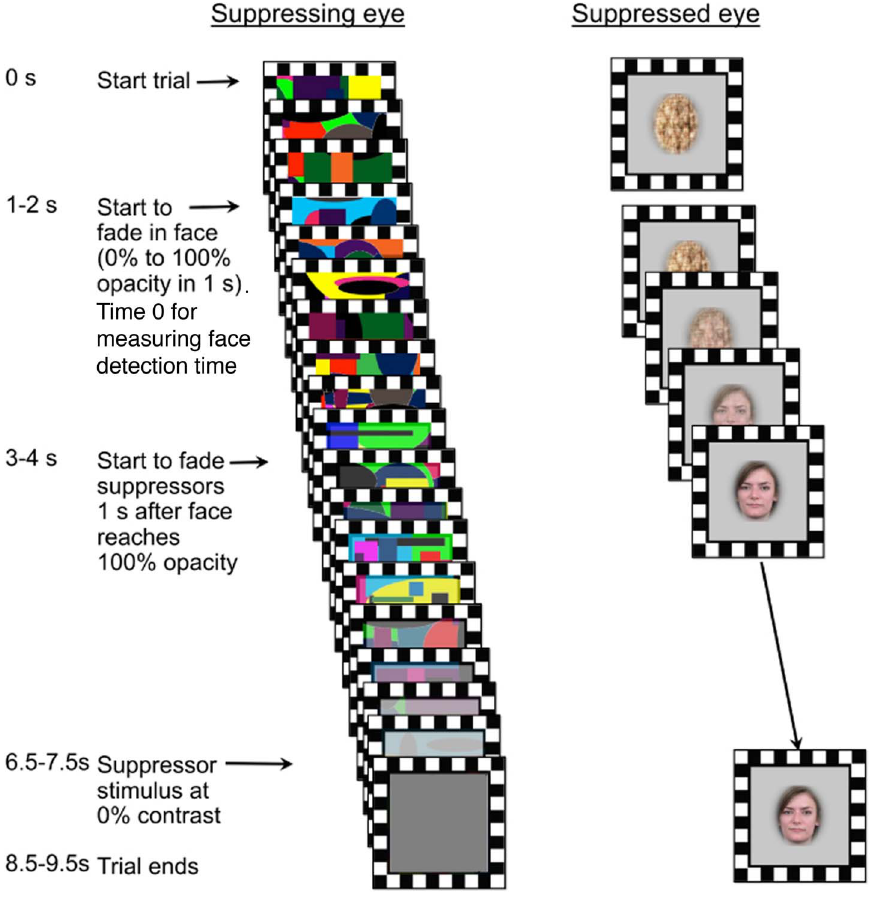
Figure 3. Continuous Flash Suppression (CSF) paradigm. Different high contrast collages of colored shapes were presented to one eye at 10 Hz. A phase-scrambled image that faded into an intact face image over 1 s was presented to the other eye. After the intact face was at full opacity for 1 s, the suppressing stimuli slowly faded to a gray square.